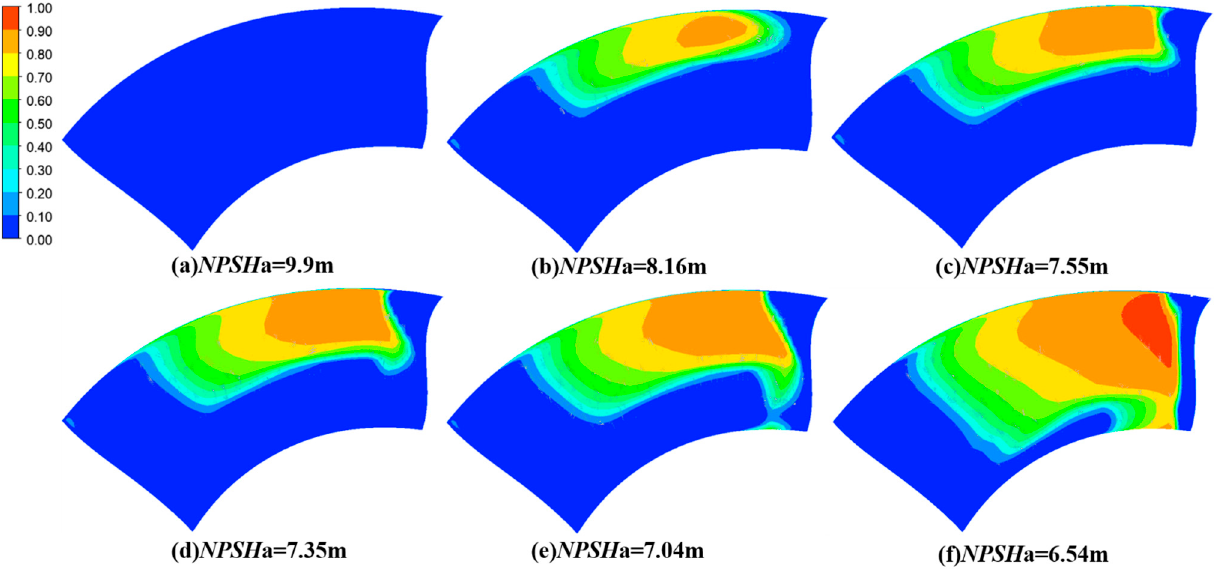
Figure 10. The distribution of the cavitation region of the impeller suction surface under different cavitation conditions.